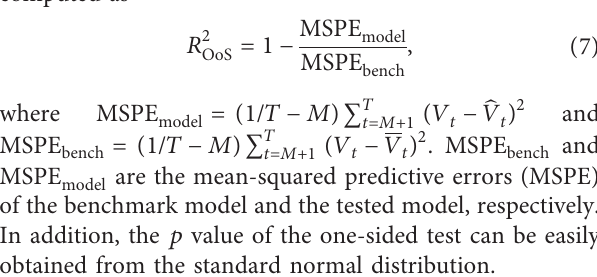
Table 1: Summary statistics. Mean Median S. E. Max. Min. Skew. Kurt.